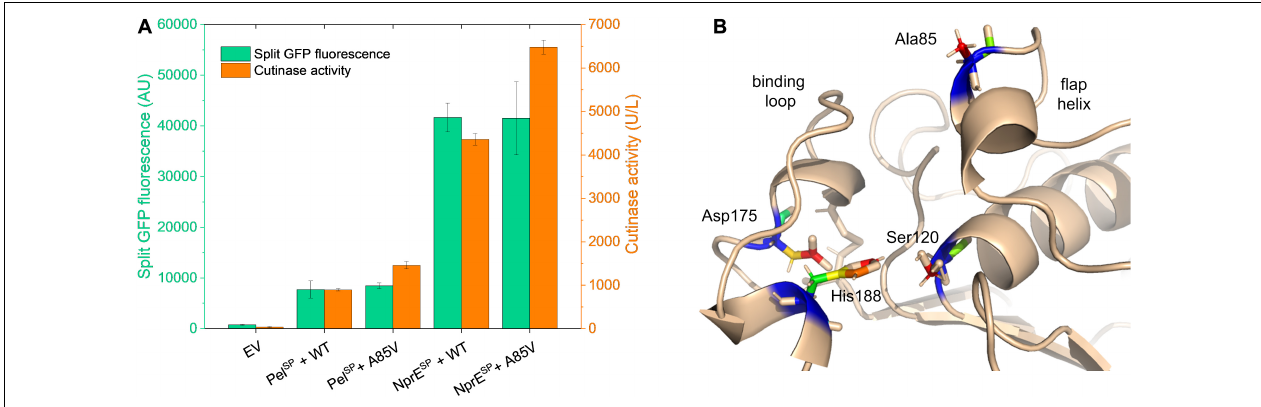
FIGURE 6 | Influence of the mutation A85V on the cutinase secretion and activity. (A) C. glutamicum K9 biosensor cells were transformed with pPBEx2-Pel-cutinase-GFP11 or pPBEx2-NprE-cutinase-GFP11 plasmid harboring either wild-type (WT) or A85V cutinase, as indicated. Biosensor cells carrying pPBEx2 (EV) served as control. The recombinant strains were grown in CGXII medium containing 1% (v/v) glucose in a BioLector for 24 h at 30 ◦ C, 1,200 rpm and 85% relative humidity. Four hours after inoculation, IPTG was added to the cultures to a final concentration of 250 µ M. At the end of the cultivation (24 h), the secretion performance was assessed by measuring the split GFP fluorescence (green bars) and the cutinase activity (orange bars), respectively. (B) 3D-representation of the X-ray structure of Fusarium solani pisi cutinase (PDB: 1CEX) showing the catalytic triad Ser120-Asp175-His188 and the binding loop, which are essential for cutinase activity. The cutinase mutation A85V, which increases the enzyme activity toward p NPP, maps to the flap helix, which lines up with the substrate-binding